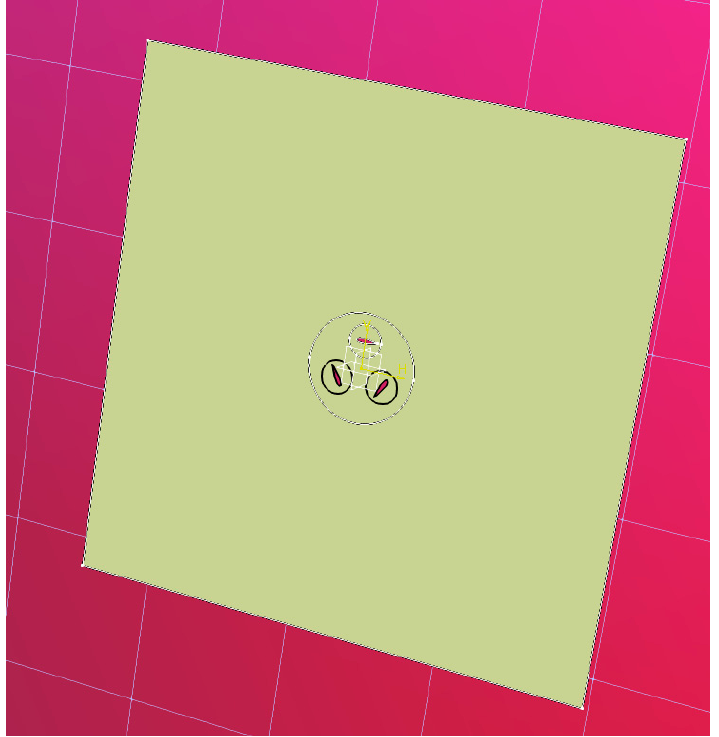
Figure 6. Sketch of the Darrieus rotor blades in CATIA. The mesh was generated in ANSYS Mesh using the proximity and curvature advanced size function. The mesh is shown on the Figure 7.